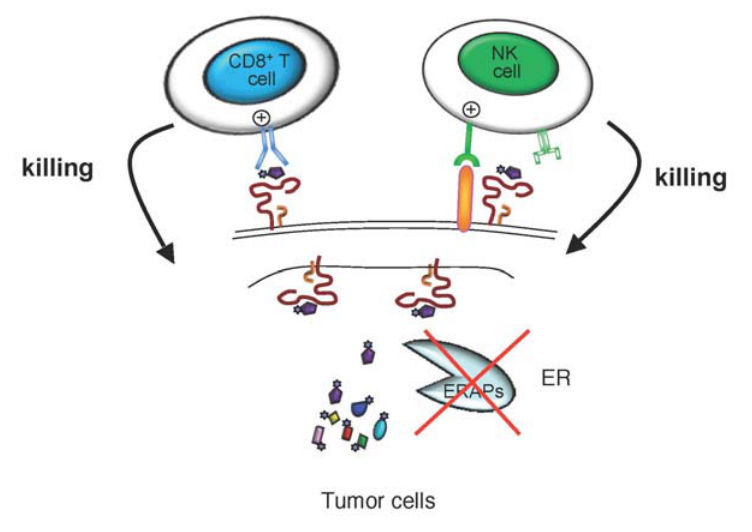
Figure 2. ERAPs inhibition: a possible novel strategy for anticancer immunotherapy. Antigenic peptides are generated in the cytosol and further trimmed at the NH the endoplasmic reticulum (ER) by ERAP1 and ERAP2 (ERAPs) aminopeptidases before being loaded onto MHC class I molecules. Peptide-MHC (pMHC) class I complexes are presented on the plasma membrane to be recognized by T cell antigen receptor on CD8 + T cells and by inhibitory receptors on NK cells. In the absence of ERAPs, a distinct repertoire of unstable pMHC class I complexes is produced and exported to the